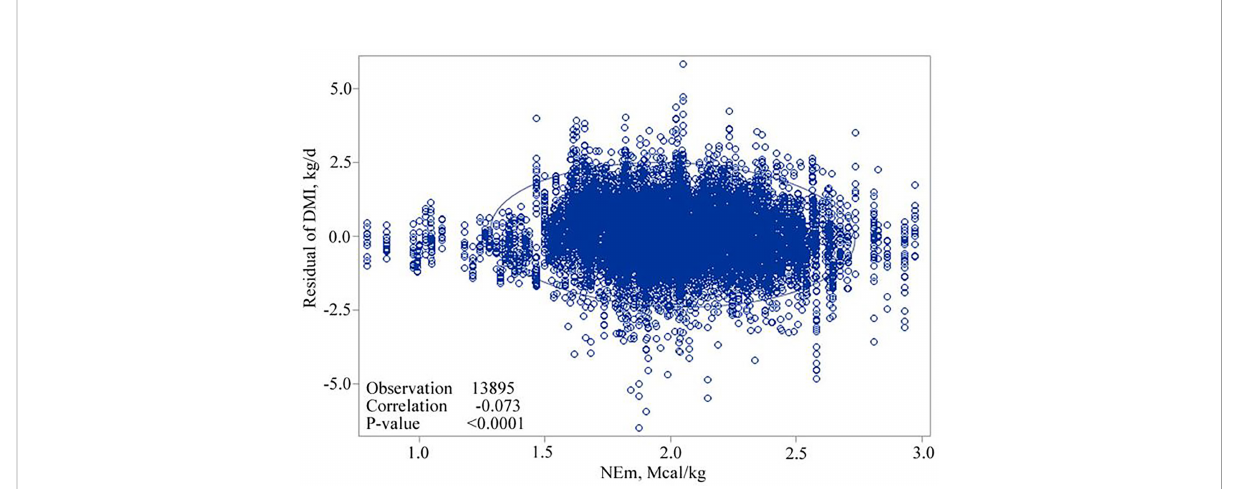
FIGURE 2 Scatter plot showing the relationship of residuals of dry matter intake (DMI) against net energy for maintenance (NE m , Mcal/kg of